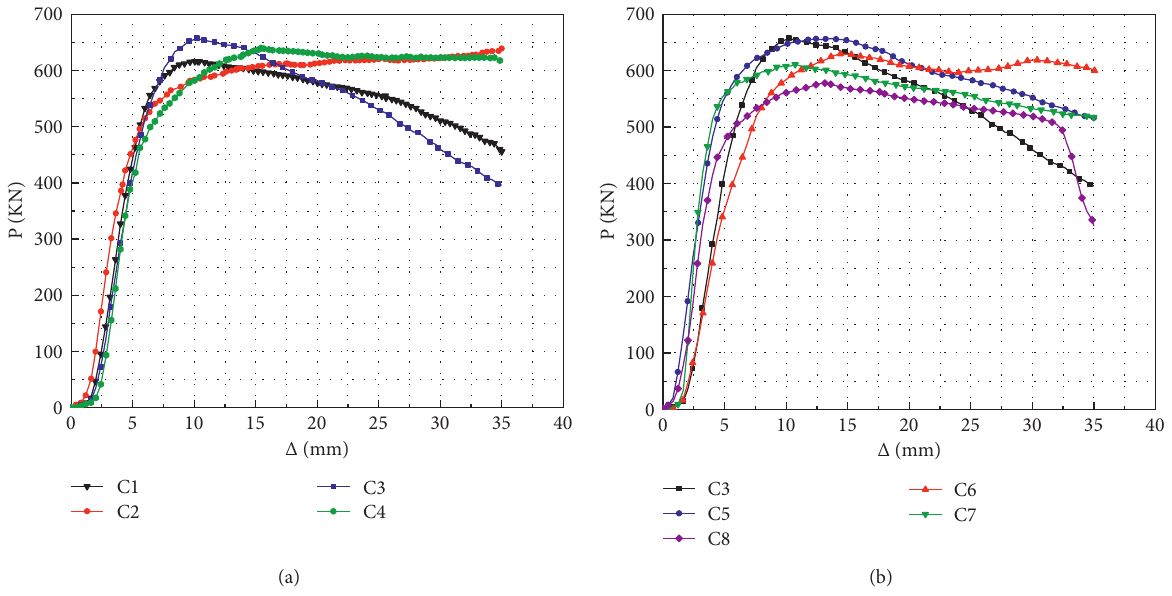
Figure 4: Load-displacement curve of tested specimen. (a) Load-displacement curve with different LS replacement rates. (b) Load-dis- placement curve with different RCA replacement